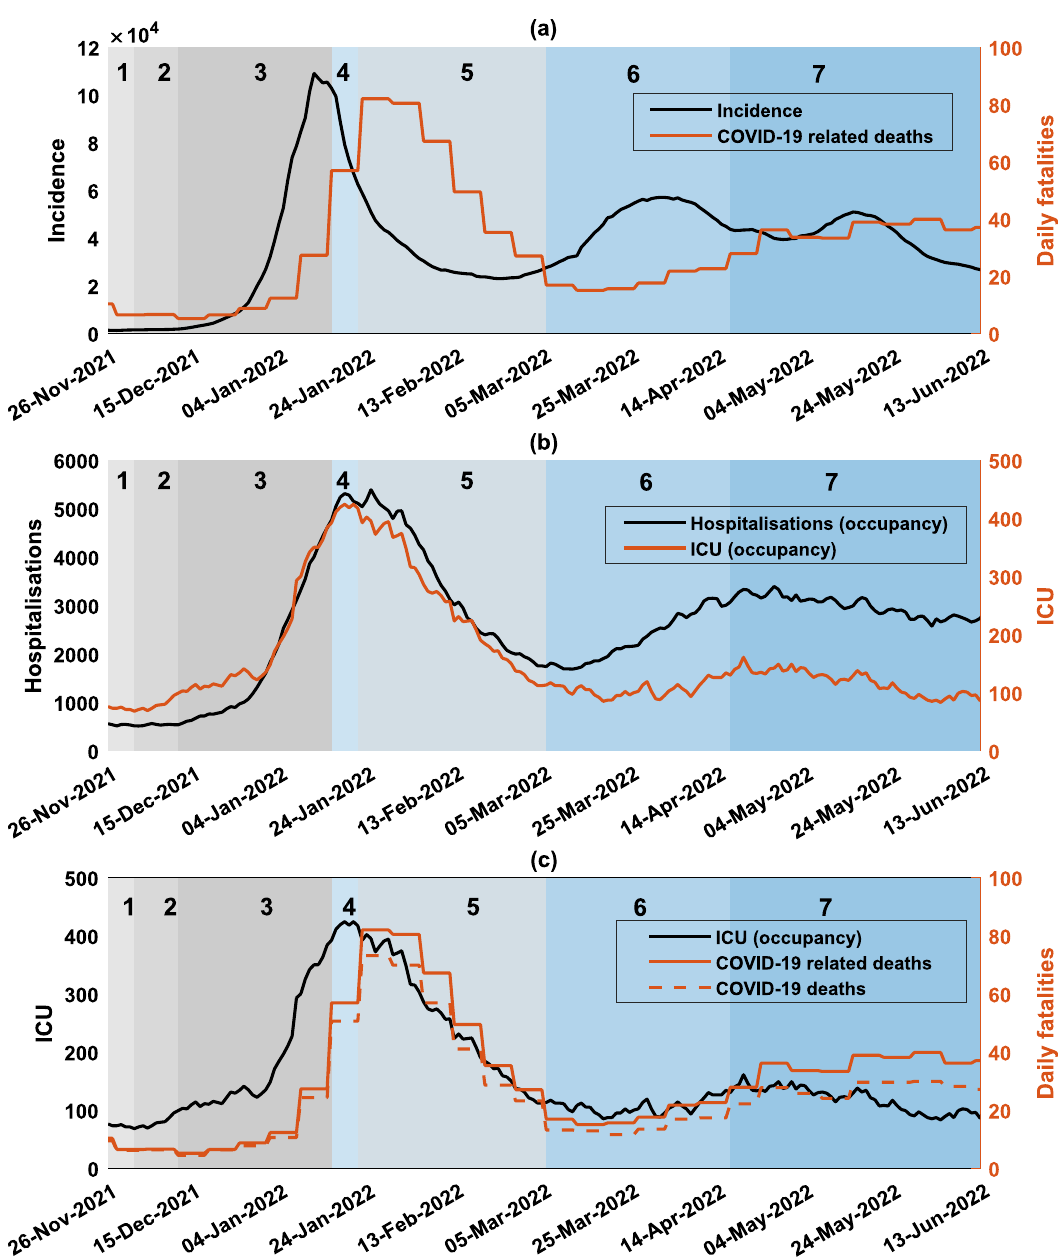
Fig 1. Incidence and disease burden of COVID-19 in Australia between 26th November 2021 and 13th June 2022. Shaded areas in grey and blue show the emergence of variants of concern and sub-lineages over time, identified in weekly genomic surveillance reports (NSW Health). Top (a): Black (y-axis, left): a 7-day moving average of reported COVID-19 daily incidence. Orange (y-axis, right): COVID-19 related deaths. Middle (b): Black (y-axis, left): COVID-19 hospitalisations (bed occupancy). Orange (y-axis, right): COVID-19 ICU cases (bed occupancy). Bottom (c): Black (y-axis, left): COVID-19 ICU cases (bed occupancy); Orange (y-axis, right): Daily COVID-19 related deaths (solid), daily COVID-19 deaths (dashed). The data for COVID-19 cases, hospitalisation and ICU occupancy, and mortality are published by the Australian